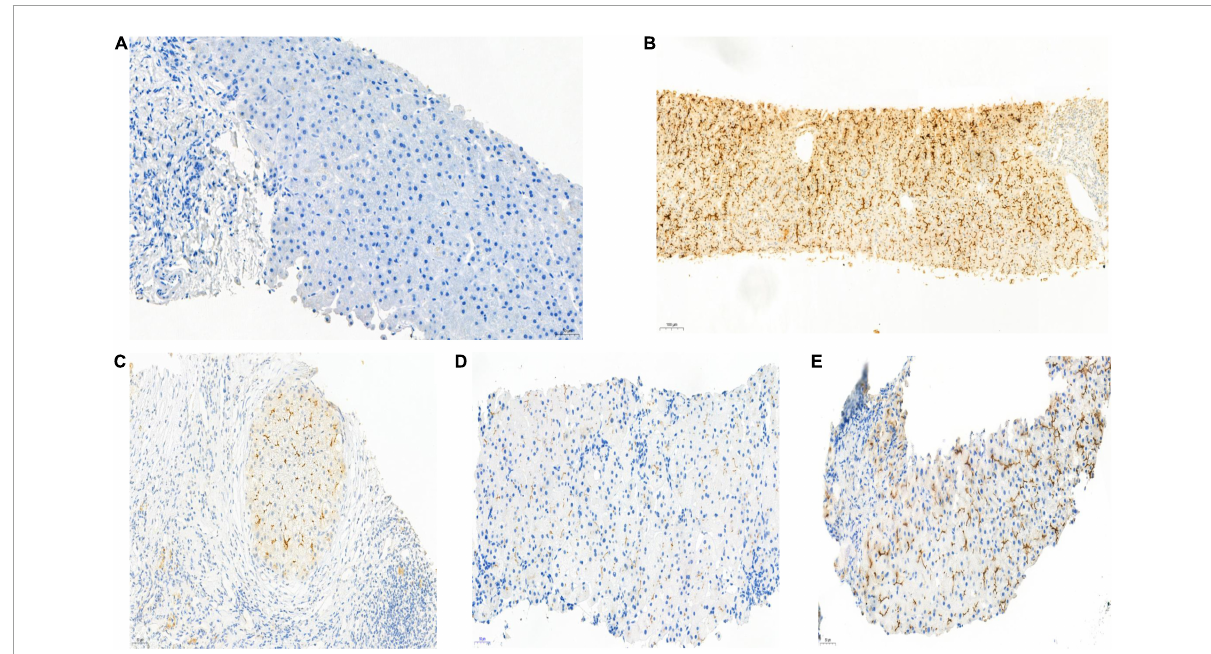
FIGURE3 Biopsy specimens of liver samples expressing Multidrug-Resistant Protein 3. (A) Normal MDR3 expression is visible in liver biopsy samples from a healthy individual. (B) Liver biopsy specimens from Case 2: loss of MDR3 expression. (C–E) Liver biopsy specimens from Case 1, 3, and 4: The MDR3 staining was significantly reduced. Images showing immunohistochemical staining at a magnification of 200 × .